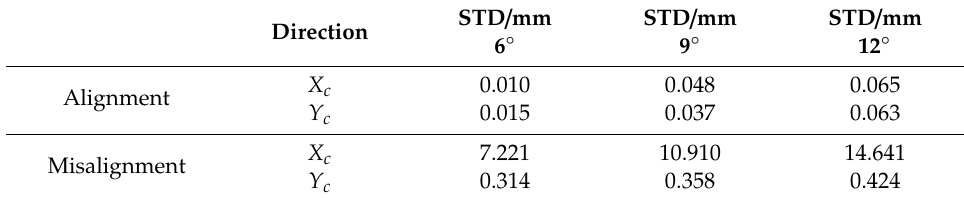
Figure 17. The comparative diagrams of the marked points of ( a ) 6°; ( b )9°; ( c ) 12°.